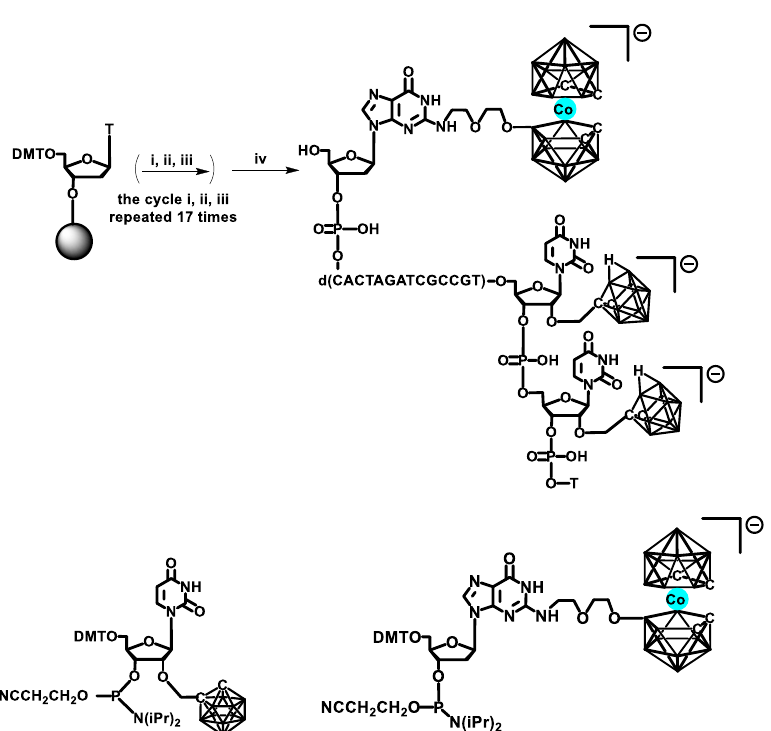
Scheme 3. Solid-phase synthesis of DNA modified with carborane and metallacarborane using phosphoramidite chemistry: (i) detritylation, (ii) coupling, (iii) oxidation and capping, and (iv) cleavage from the solid support and deprotection [25]. Hydrogen atoms of C–H groups and B–H groups of the boron clusters, symbolized by the polygen vertex, were omitted for clarity.